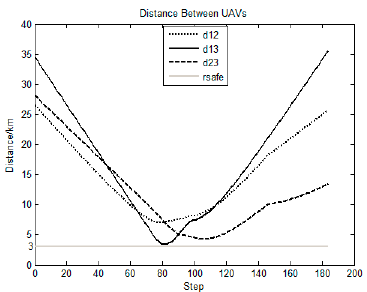
Figure 10. Distance between UAVs.